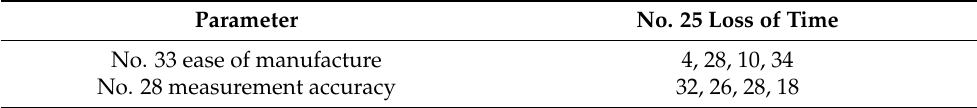
Table 1. Contradiction matrix table obtained by parameter.